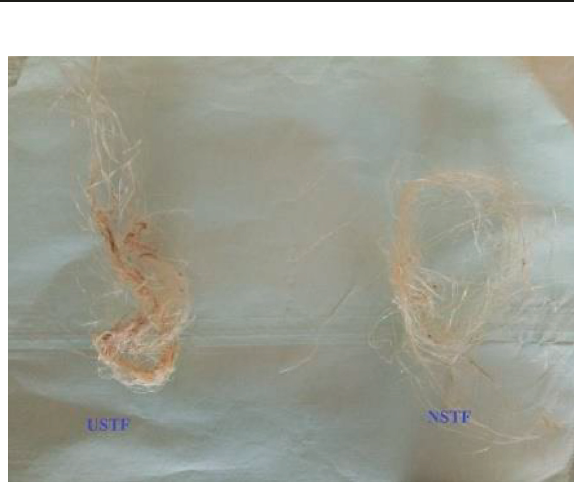
Figure 2: Extracted fiber with untreated and NaOH treated.